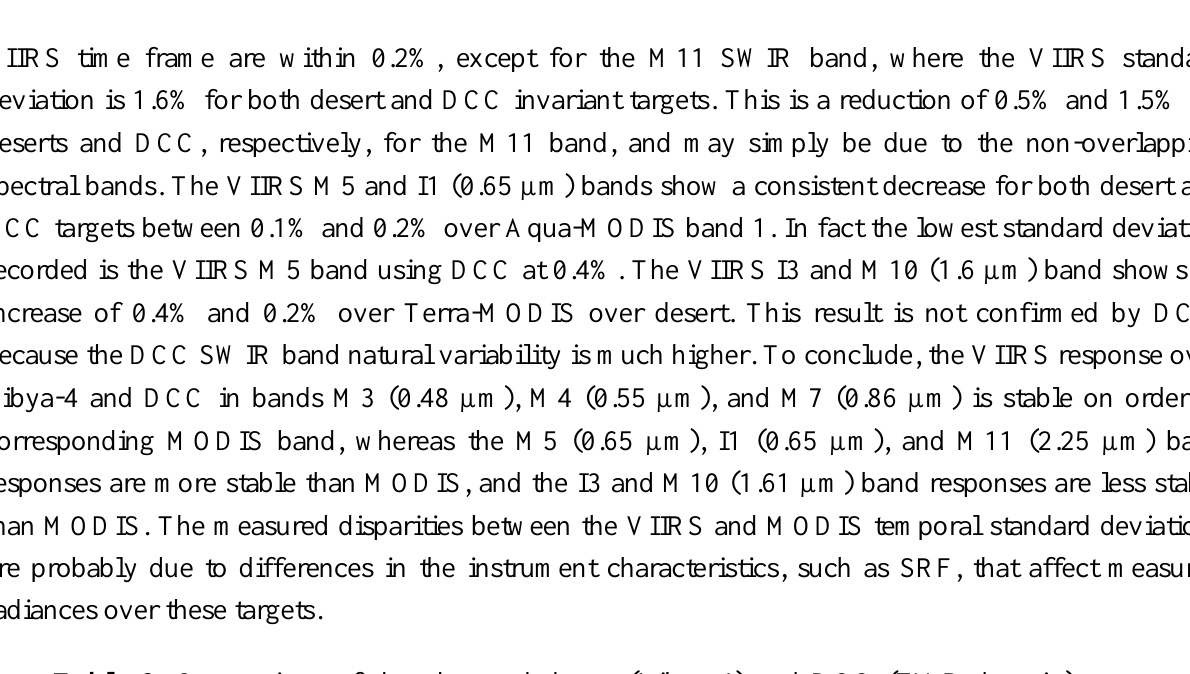
Table 2. Comparison of the observed desert (Libya-4) and DCC (TWP domain) target stability (%) computed from the full MODIS record (July 2002 to October 2013) and during the VIIRS time frame (February 2013 to October 2013), and from VIIRS